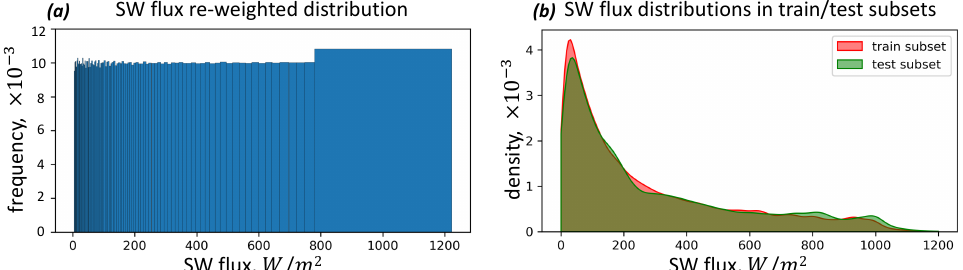
Figure 2. ( a ) Effective distribution of target values (SW radiation flux) in the train subset as a result of ITF re-weighting. One may clearly see that re-weighted frequencies of various ranges are close to each other (bars have almost the same height); thus, one may consider the dataset balanced. ( b ) Distribution of target value (SW radiation flux) in training and test subsets without ITF re-weighting. One may clearly see that the distributions are